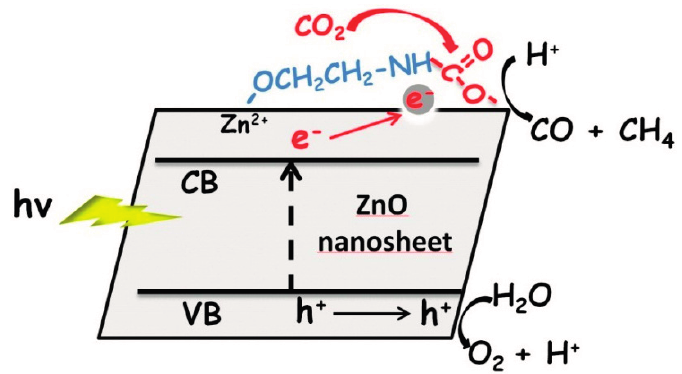
Figure 7. Schematic illustration of adsorption and photoreduction of CO 2 on the MEA-functionalized ZnO